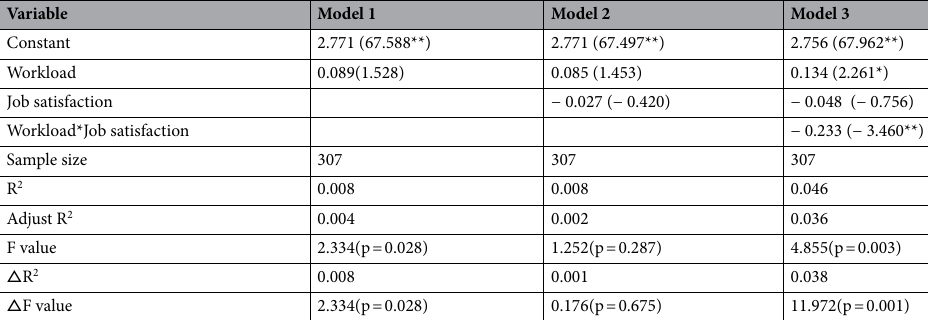
Table 8. The results of the moderating effect of job satisfaction on workload and miners’ unsafe state. R 2 is the square of multivariate correlation coefficient. F represents the analysis of variance test statistic. p represents the significance value. *Represents a significant level at p < 0.05. **Represents a significant level at p < 0.01.